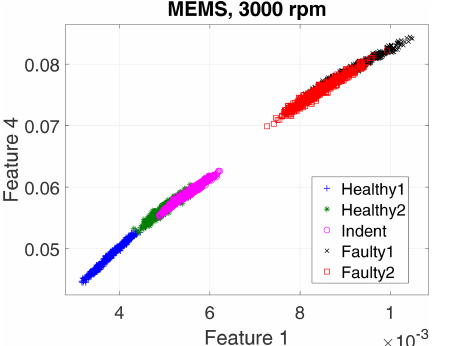
Table 3. Confusion matrix for 3000rpm MEMS data and the top three features.